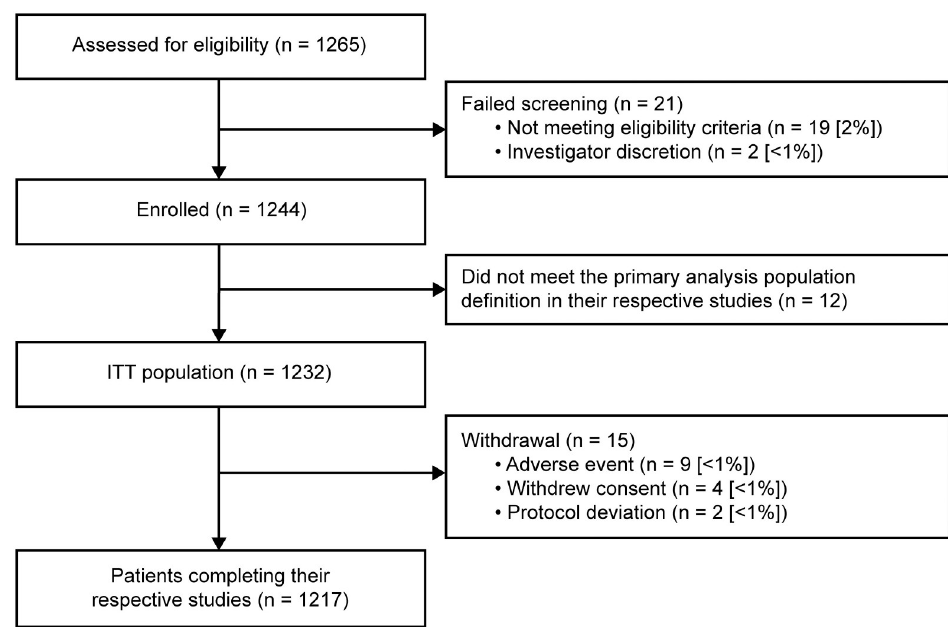
Fig 2. Patient flow, including study completion and withdrawal. ITT, intent-to-treat.